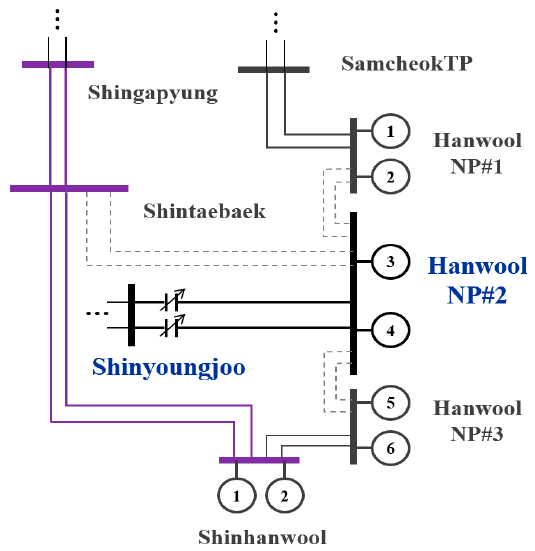
Figure 13. Single line diagram near TCSC.